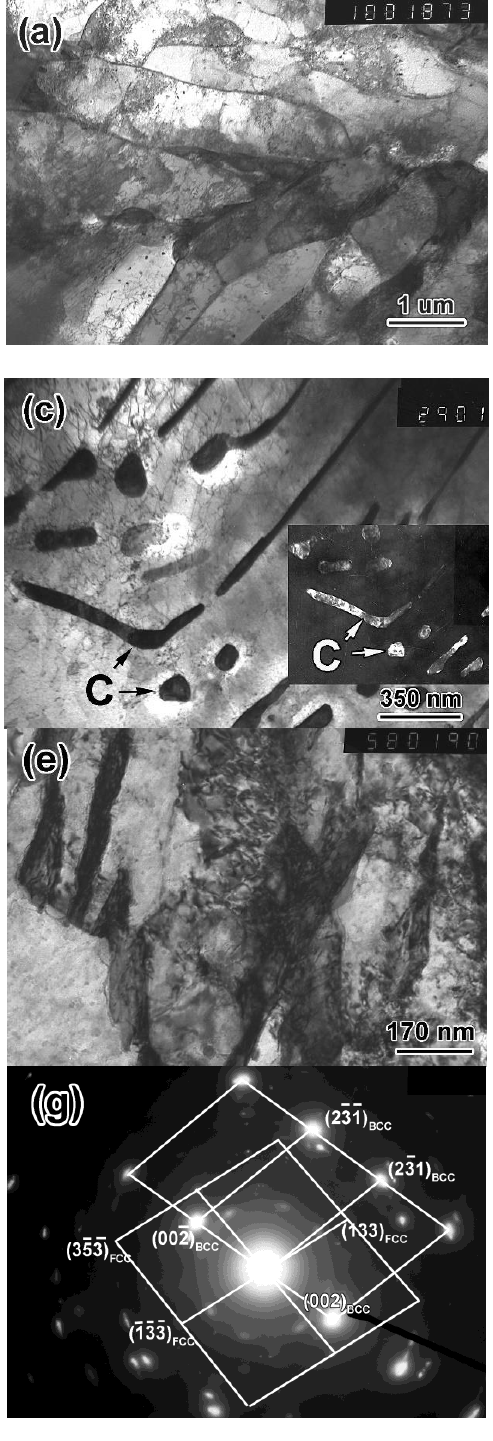
Figure 7. TEM images of the specimens austenitized at 770 °C ( a – d ) and 830 °C ( e – h ). ( a ) The sub- structure of bainitic ferrite, ( b ) nano-scaled carbides and dislocation clots, ( c ) the cementite precipitates between the ferrite laths, and the dark-field image in a cementite reflection (insert), ( d ) SAED pattern of ( c ) showing the reflection on the [ 1 2 0 ] zone axis of cementite, ( e ) bright-field image of ferrite laths and RA films, ( f ) dark-field image of ( d ) in austenite reflection, ( g ) SAED pattern of ( f ) showing the reflection on the [320] zone axis of ferrite and the [ 7 36 ] zone axis of austenite, ( h ) dislocation walls inside the ferrite laths. (C is cementite, BCC is ferrite, and FCC is austenite).